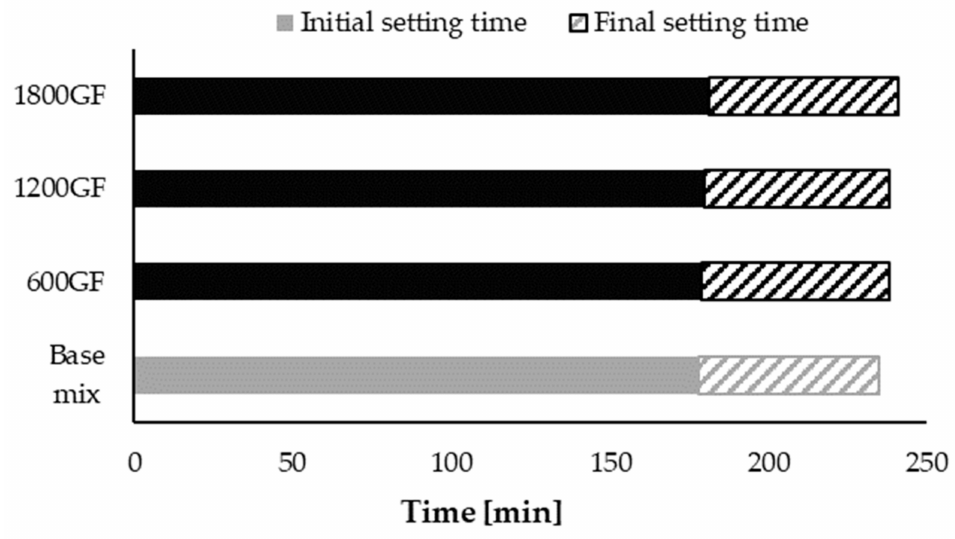
Figure 4. Initial and final setting times distribution of tested mixes: GF marked in black, base mix (no fibers) marked in dark grey.